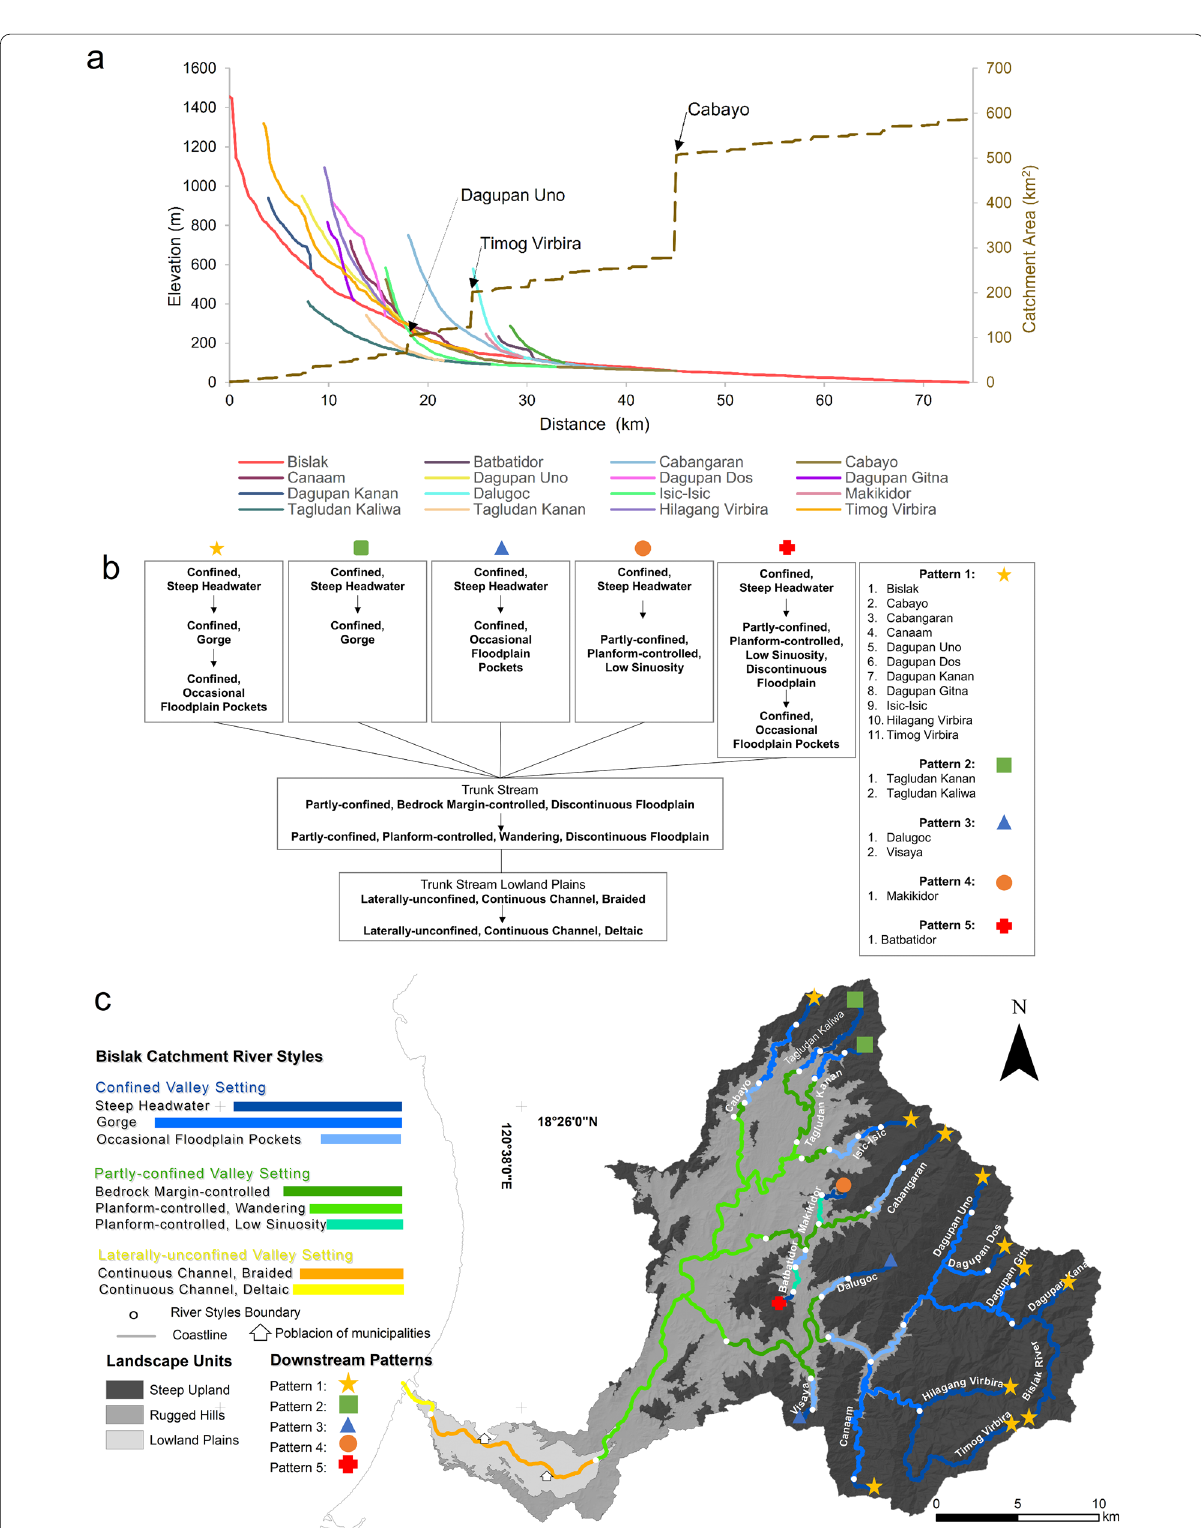
Fig. 4 Downstream patterns of River Styles in the Bislak Catchment. a Longitudinal profiles of the tributaries of the Bislak River. b Flow diagram of downstream patterns in the catchment and list of tributaries exhibiting each pattern. c Distribution of downstream patterns across the